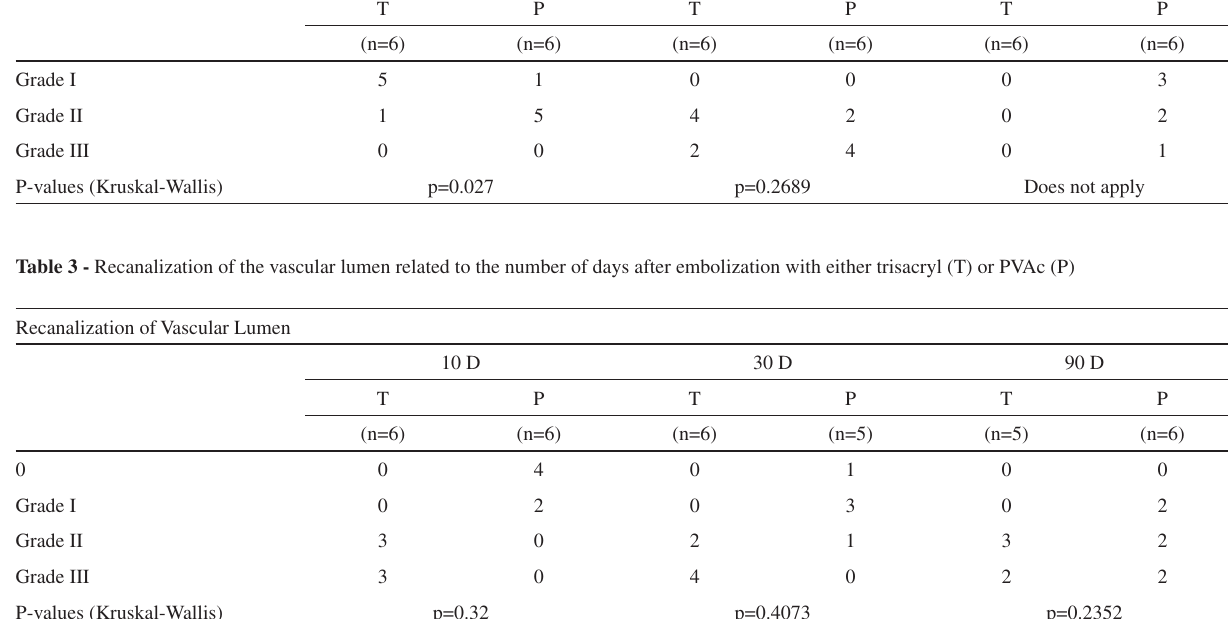
Table 2 - Vascular wall necrosis related to the number of days after embolization with trisacryl (T) or PVAc (P) Vascular Wall Necrosis